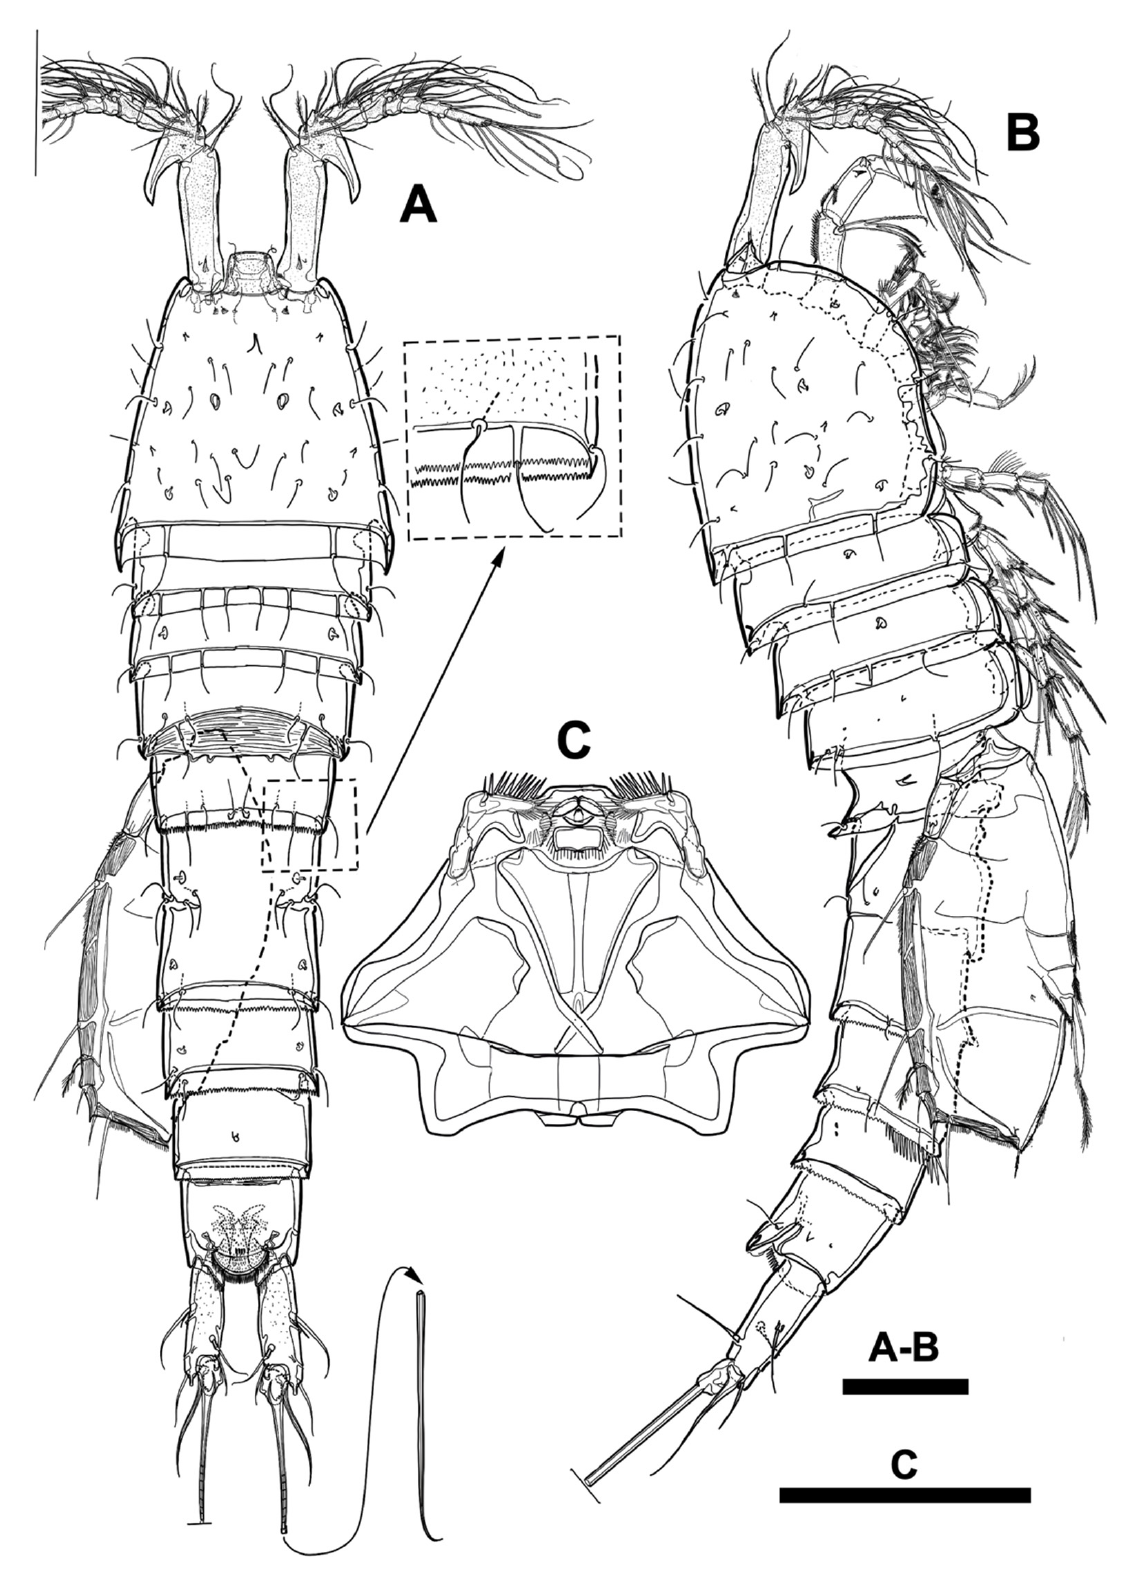
Figure 7. Line drawings of Phyllopodopsyllus saywakimi sp. nov. female (holotype): ( A ) habitus, dorsal; ( B ) habitus, lateral; ( C ) rostrum, ventral. Scale bars: ( A , B ) 100 µm; ( C ) 50 µm.